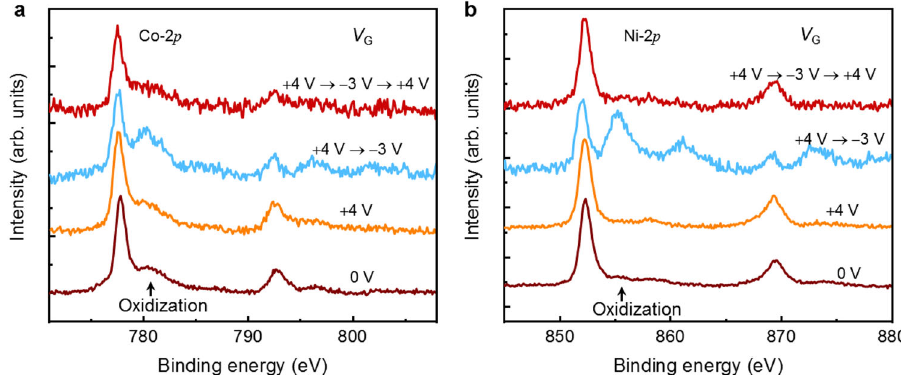
Fig. 3 ILG-induced ion migration in SAF structures. X-ray photoelectron spectra (XPS) of a Co-2 p , b Ni-2 p for SAF samples gated at various V G applied in the following sequence: 0 V (pristine state), + 4 V, + 4 V → − 3 V, and + 4 V → − 3 V → + 4 V.